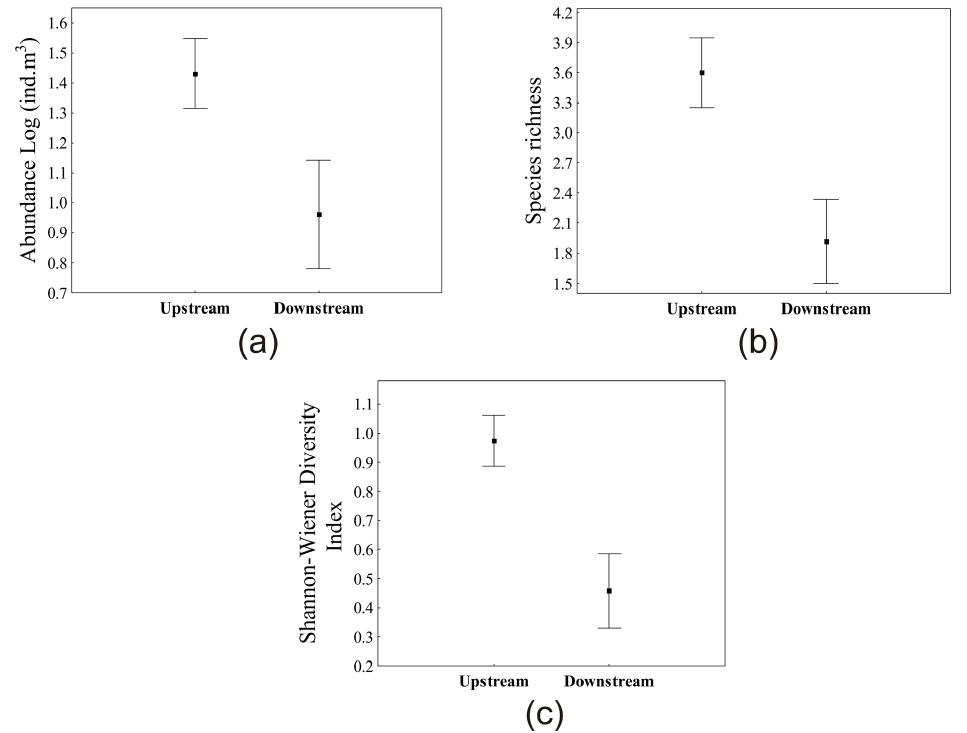
Figure 5. Copepod abundance of organisms (a), species richness (b) and diversity (c) recorded in the tributaries sampled in the different stretches (upstream and downstream) of the Paraná River. Symbols represent mean values and vertical bars represent standard